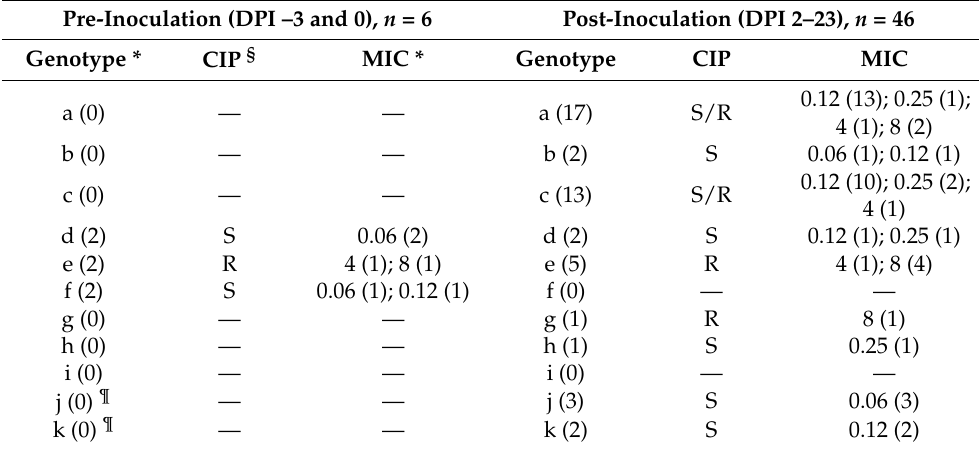
Table 3. PFGE profiles and ciprofloxacin MICs of C. jejuni isolates obtained from calves that did not receive enrofloxacin (Group 1) #